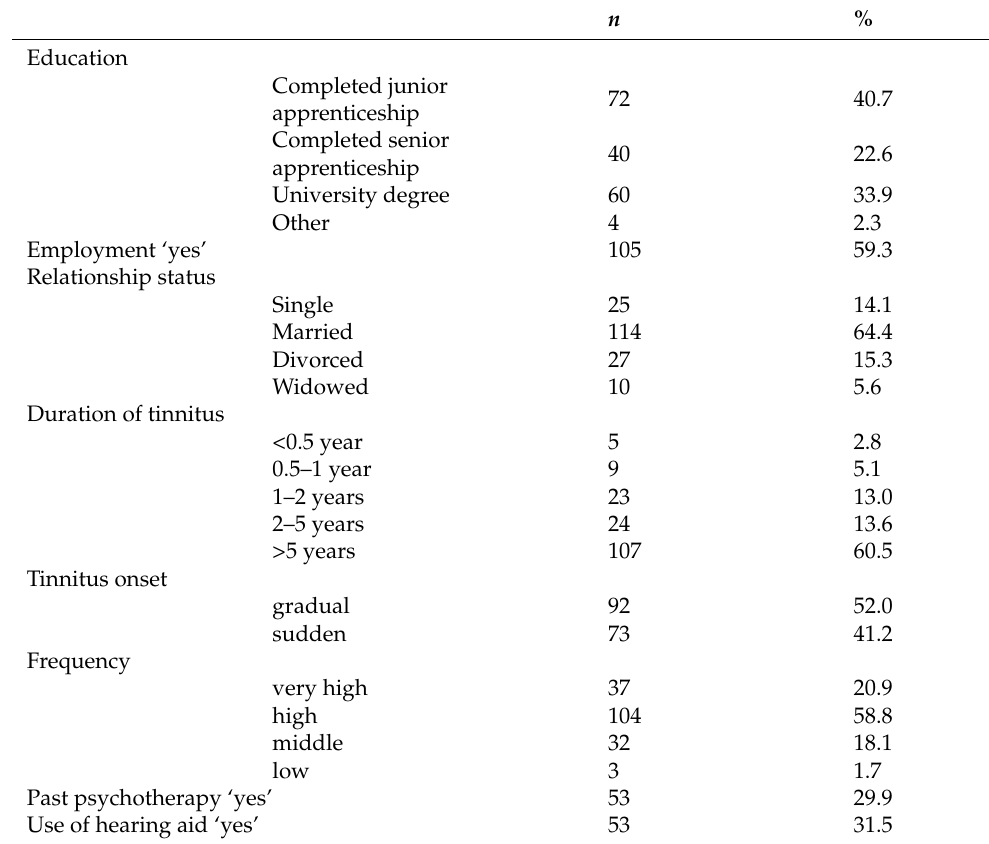
Table 1. Sociodemographic data and patient characteristics ( n =